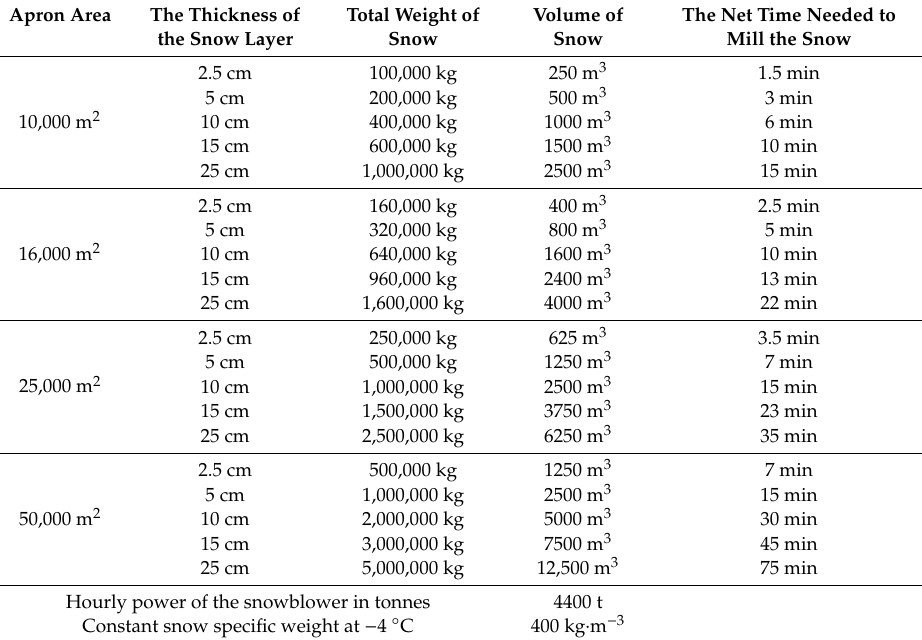
Table 4. The time needed for milling of snow